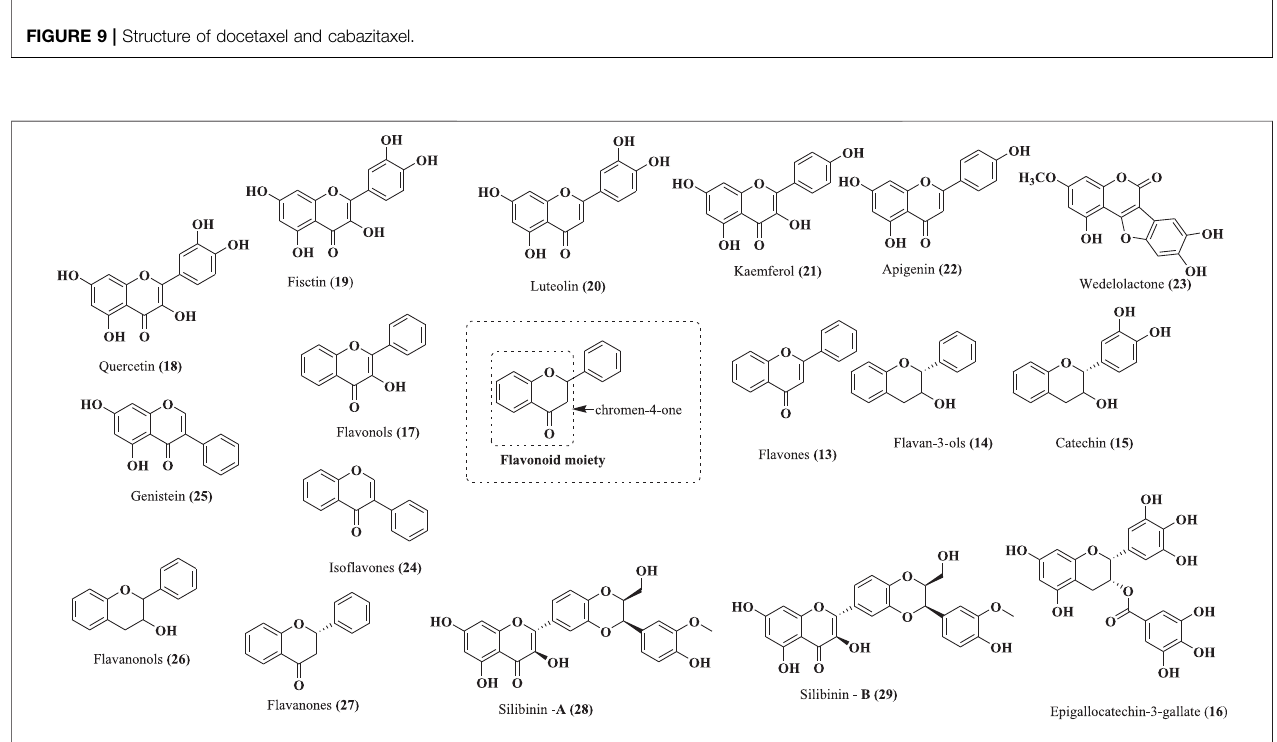
FIGURE 9 | Structure of docetaxel and cabazitaxel.